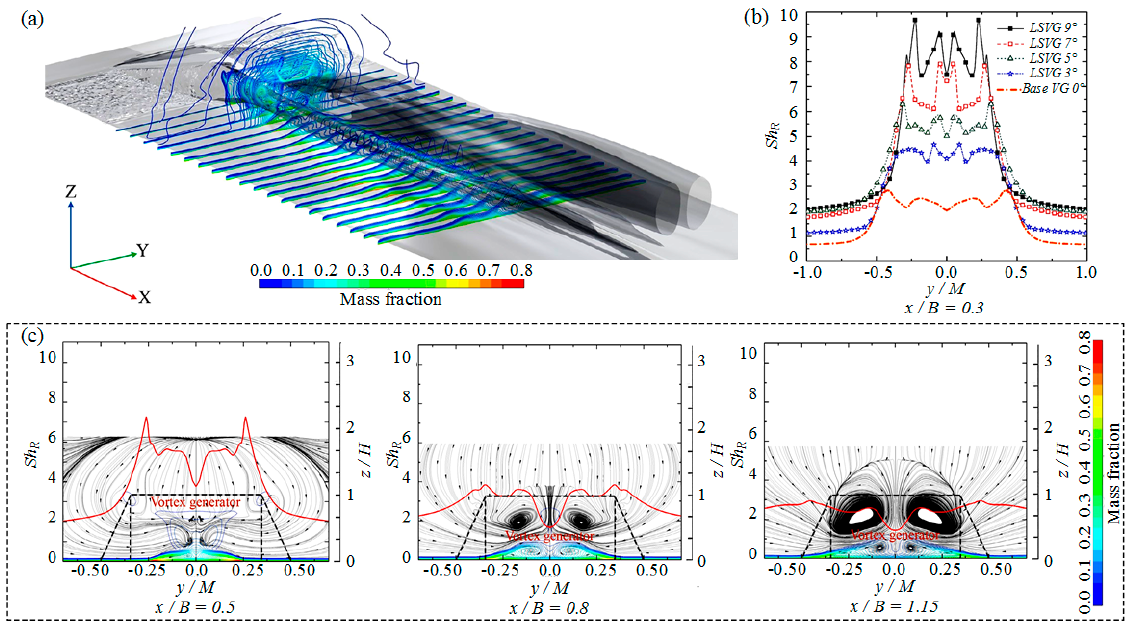
Figure 4. Mass transfer process of the compressible vortex flow field. ( a ) Species profiles with mass fraction. ( b ) Mass transfer profiles at x/B = 0.3. ( c ) Streamlines of species mass fraction. (Reprinted with permission from Ref. [61]. 2017, Elsevier).